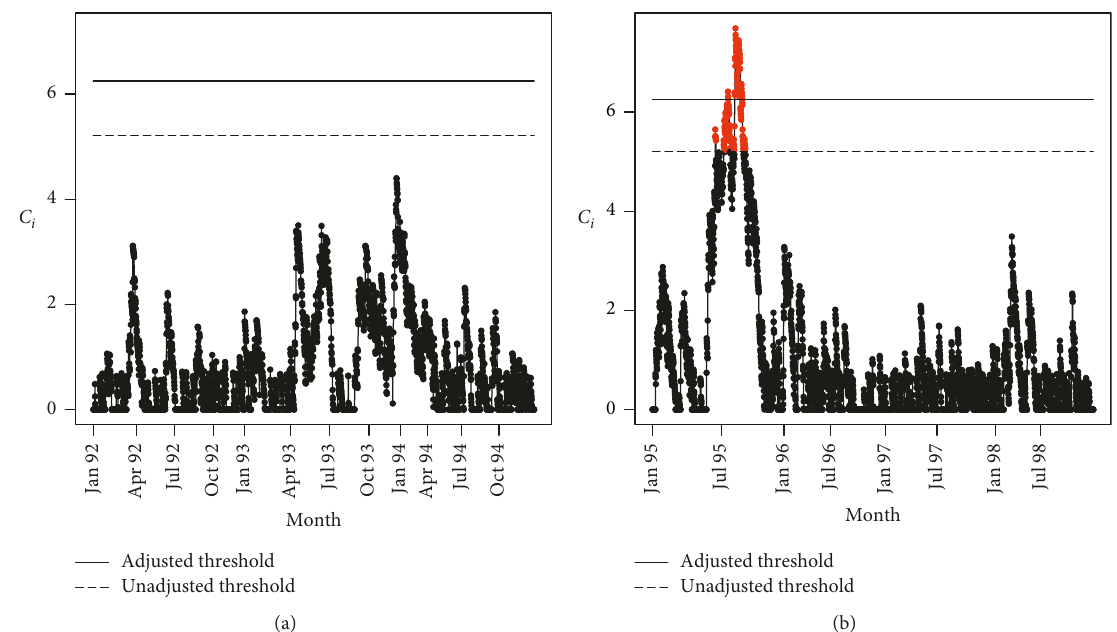
Figure 7: RA-CUSUM chart for Phase-I and Phase-II assuming first three years as the Phase-I for 30 days mortality of cardiac surgery patients. (a) Phase-I chart, unadjusted UCL � 5.208 and adjusted UCL � 6.259. (b) Phase-II chart, unadjusted UCL � 5.208 and adjusted UCL �